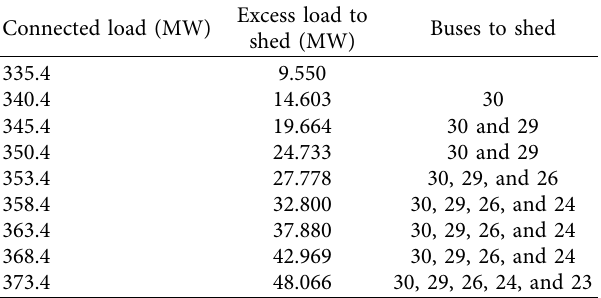
Table 3: Overload contingency